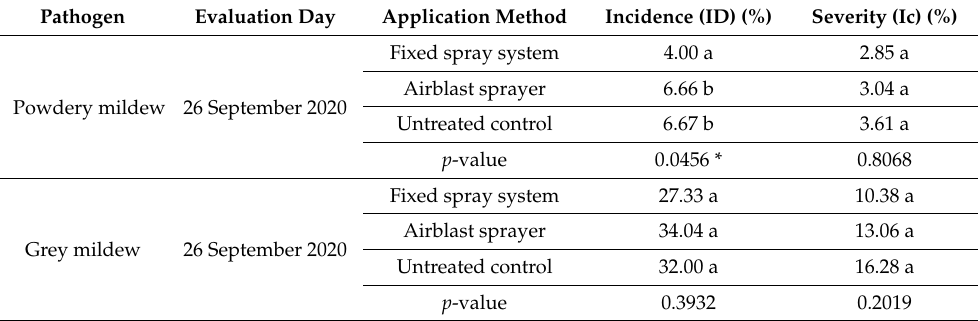
Table 6. Infection of grapevines with powdery mildew and grey mildew in Soave vineyard: com- parison between the two spray-application techniques and the untreated control. Different letters indicate significant statistical differences. * = p -value <